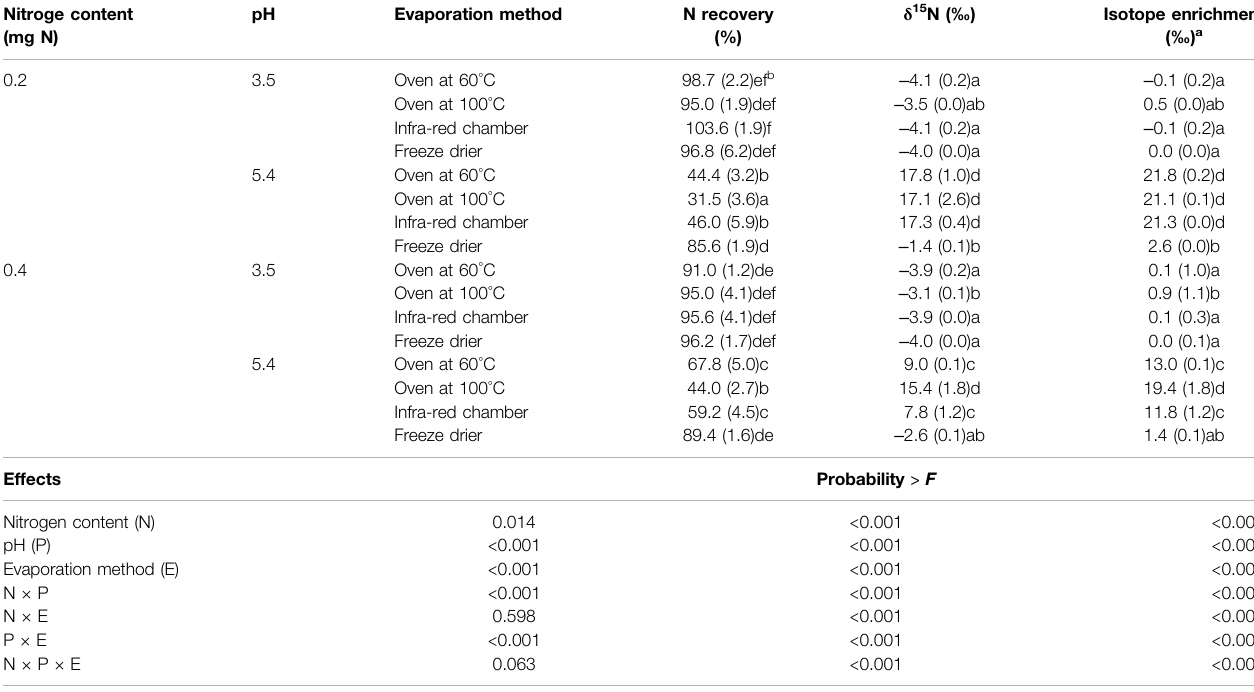
TABLE 1 | Effects of N content, pH, and evaporating methods on the N recovery and δ 15 N of (NH 4 ) 2 SO 4 ( ‒ 4.0 ± 0.03 ‰ ) solution. Nitroge content (mg